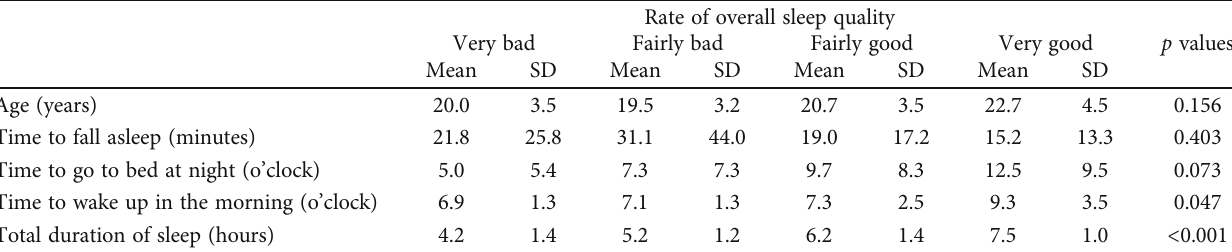
Table 2: Overall sleep quality based on age and sleep time-related variables.